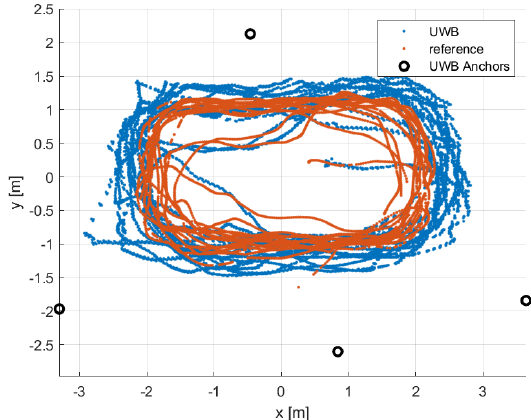
Figure 3. Comparison of UWB estimated positions (blue) with reference ones (red). The root mean square error (for the 3D position estimates, for the horizontal and vertical position error) and the maximum (absolute) error along the x and y directions are reported in the Table 1 for all the considered cases.